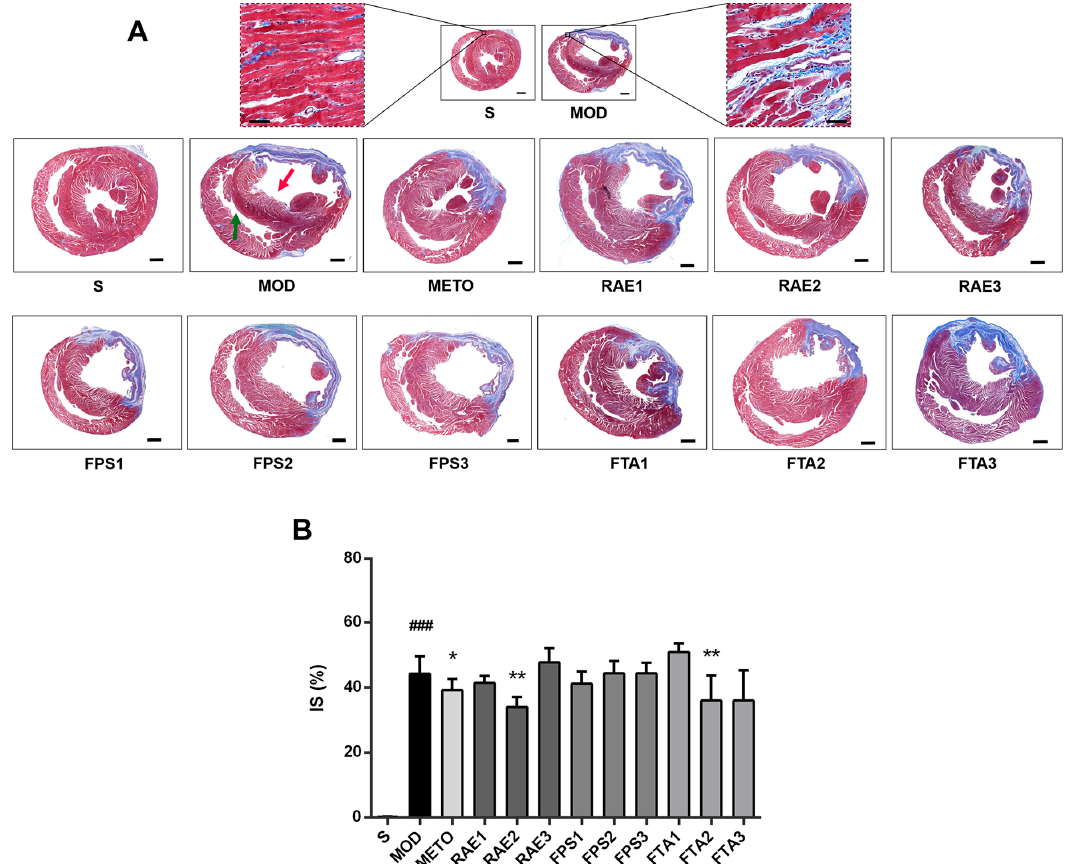
Figure 5. Photomicrographs of heart sections stained with Masson in each group (close to the coronary vein). ( A ) Magnifications of 7.1 × in cross-sectional photomicrographs of heart sections stained with Masson in each group, scale bar = 1000 μ m; magnifications of 200× in local enlarged photomicrographs near the coronary vein, scale bar = 60 μ m. The red arrow indicates the left ventricle, and the green arrow indicates the right ventricle. ( B ) Statistical analyses of infarct size (IS) using Image-Pro Plus. S, sham surgery group; MOD, MI model group; METO, metoprolol-treated group; RAE1/2/3, 1.6/0.8/0.4 g/kg Radix Aconiti Lateralis Preparata extract groups; FPS1/2/3, 1.6/0.8/0.4 g/kg fuzi polysaccharides groups; FTA1/2/3, 1.6/0.8/0.4 g/kg fuzi total alkaloid groups. Data are presented as mean ± standard error of the mean; n = 4–6 per group. ### p < 0.001 vs. S group; * p < 0.01, ** p < 0.01 vs. MOD group.